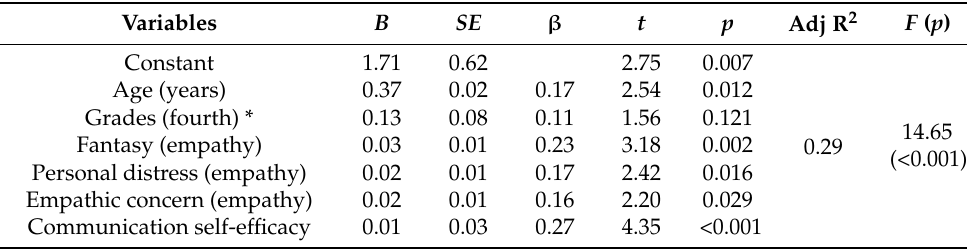
Table 5. Multiple Regression for Patient-Centered Caring (Patient–Practitioner Orientation Subscale) ( n =